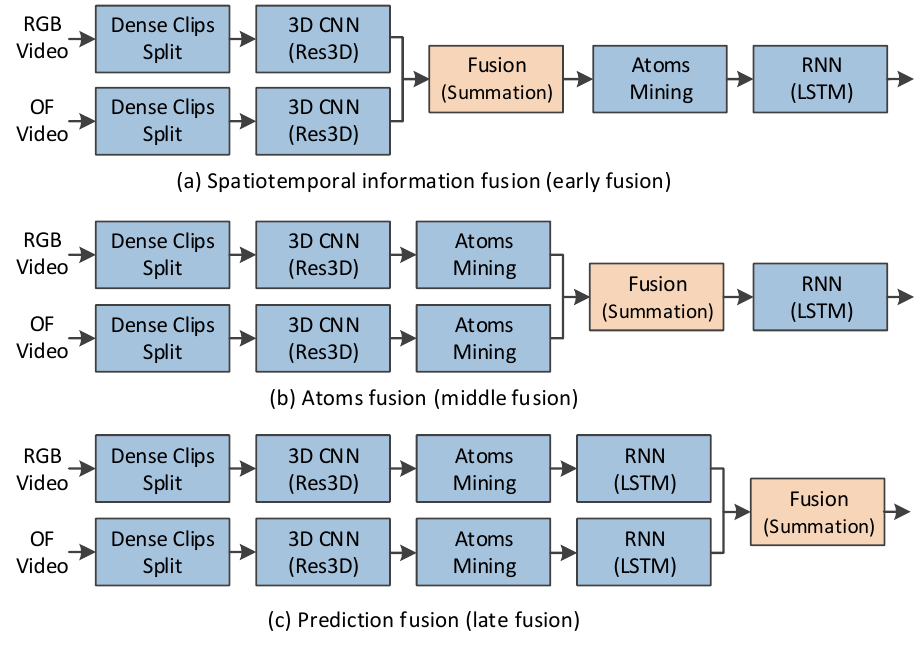
Figure 8. Fusions of the RGB and OF streams.